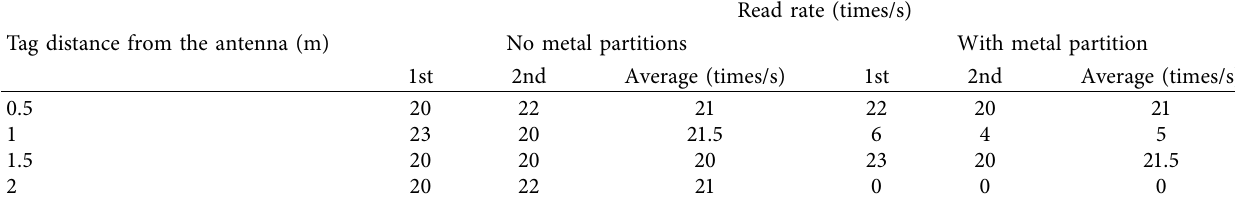
Table 3: Tag read rate.